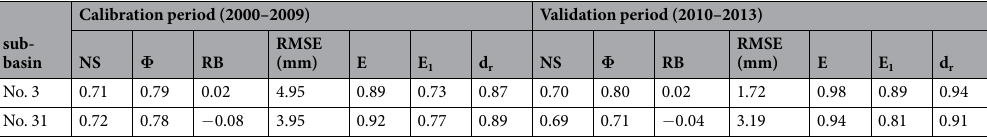
Table 2. ET simulation results at two typical sub-basins (numbers 3 and 31) for the calibration and validation